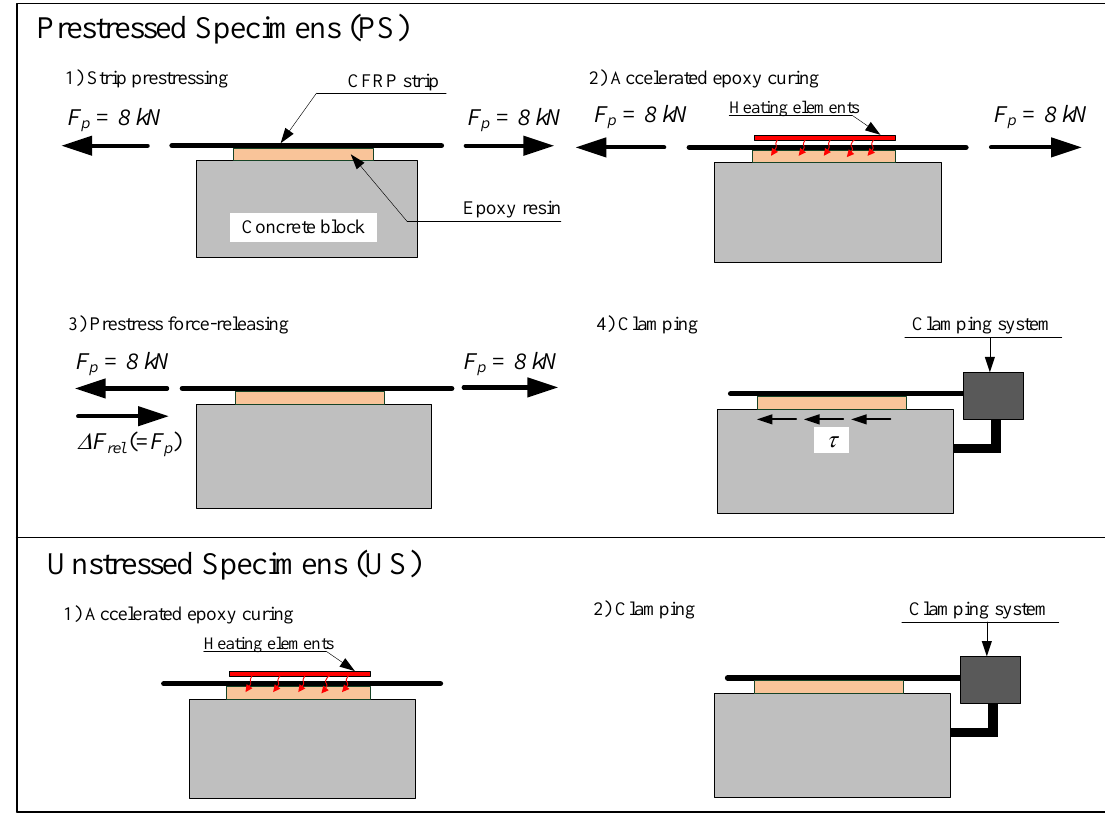
Figure 3. Key steps of specimen preparation for prestressed ( top ) and unstressed ( bottom )